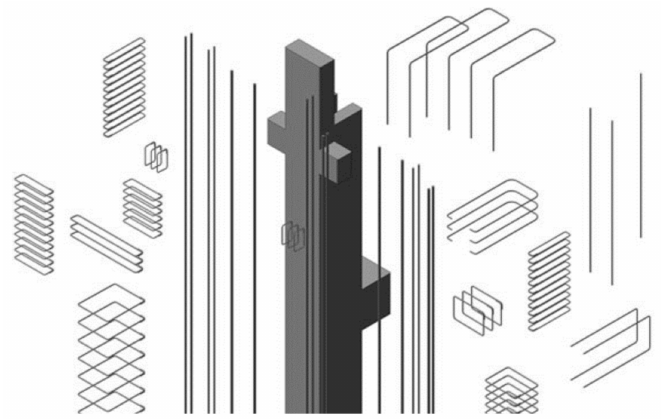
Figure 5. Exploded drawing of a reinforcement model for a column